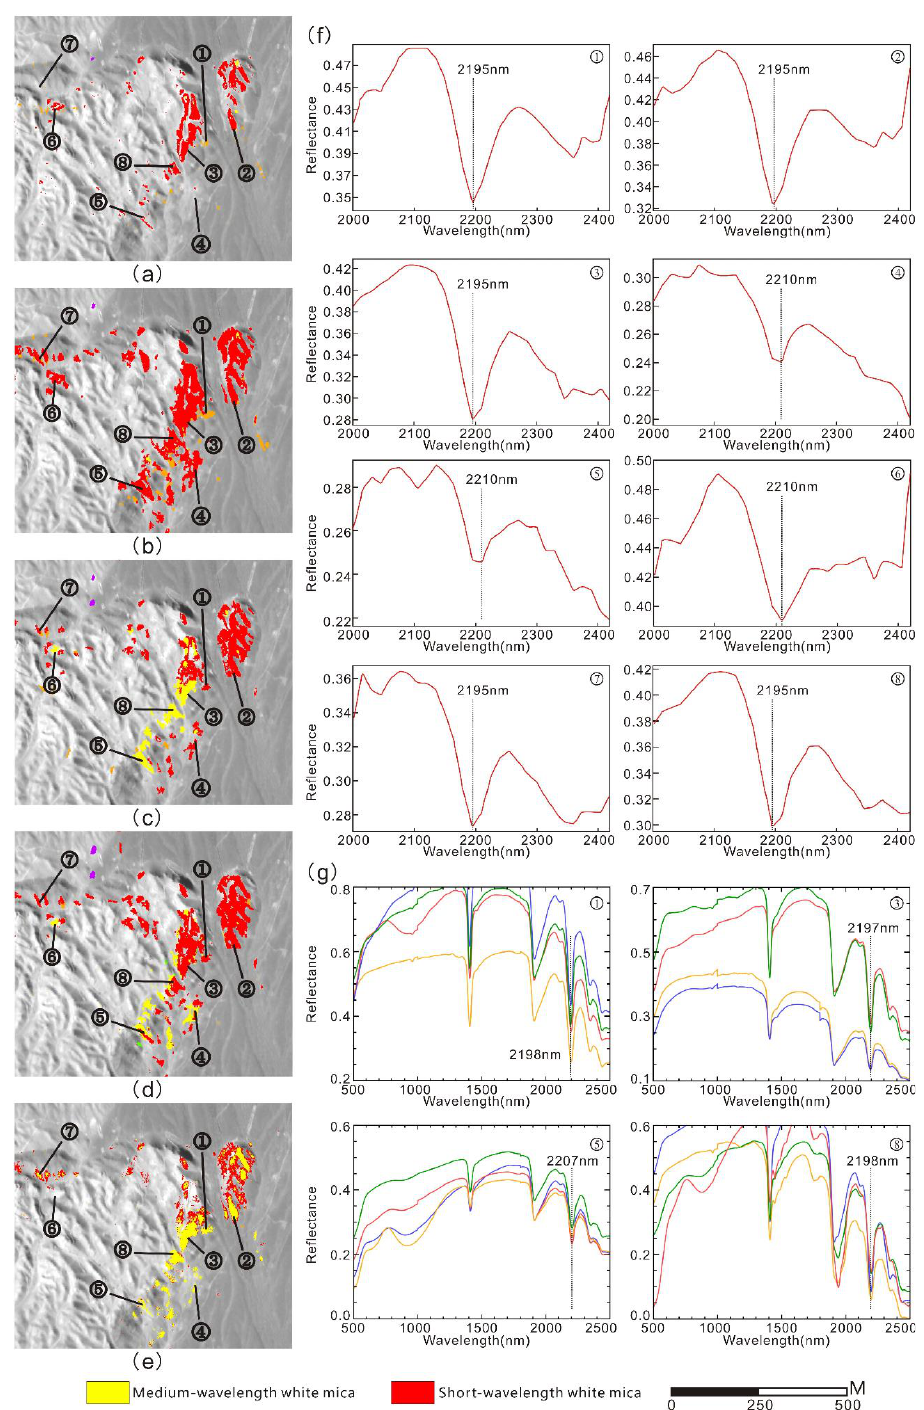
Figure 14. ( a – e ) show the mapping results of the SVM, FCNN, 1D CNN, 1D + 2D CNN models and MTMF in the northeast margin of the Yangzhuang rock body, respectively. ( f ) shows the pixel spectral curves of 8 points numbered 1 (cid:13) – 8 (cid:13) in the SASI images. ( g ) shows the spectral curves of rock samples collected at the corresponding points measured by an ASD spectrometer in the laboratory, and curves with different colors represent the measurement results of different rock